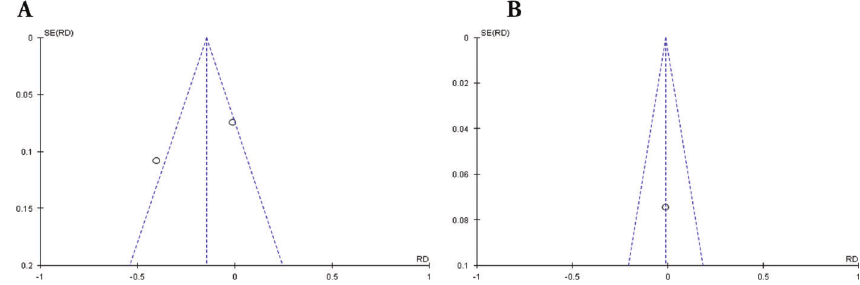
Figure 8 - Funnel plot of all complications in randomized studies. The study by Ljungdahl (3) was outside of the funnel, which could indicate important bias in the interpretation (Figure 8a, Supplementary file) that PEG is associated with fewer complications. Furthermore, its weight in the analysis was 34% lower compared with the value in the study by Stiegmann (14), or 65.1%, which led to a new analysis of sensitivity and exclusion of the study by Ljungdahl (3) (Figure 8b, Supplementary file).